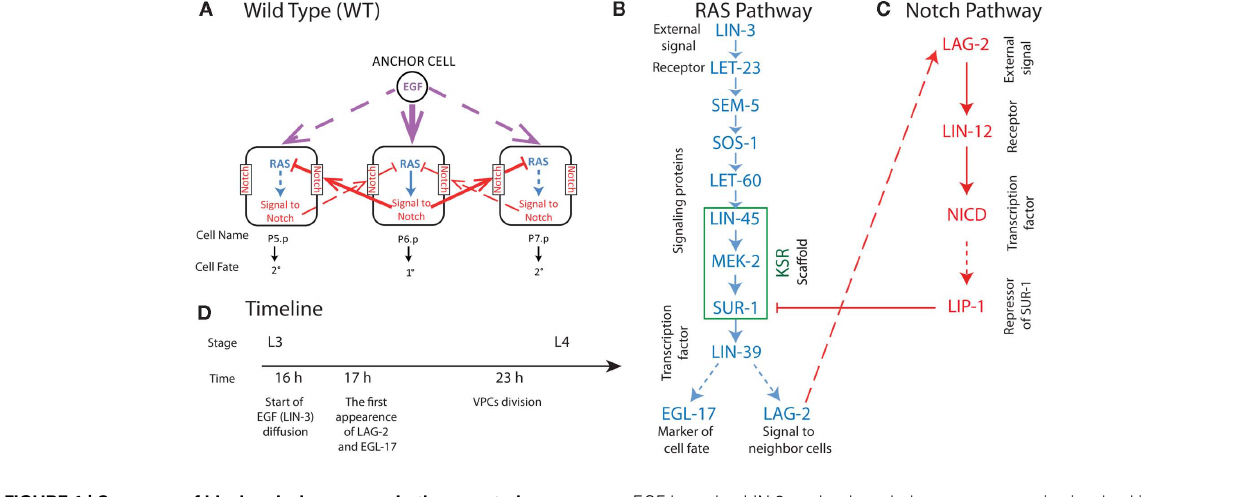
EGF homolog LIN-3, and red symbols represent species involved in Notch signaling triggered by the RAS product LAG-2 presented on the surface of neighboring cells. (D) The experimentally observed timeline of processes inVPC development at 20˚C (Euling and Ambros, 1996; Burdine et al., 1998).Where known, timing for the reactions depicted in (A–C) are in the parameter supplement available on